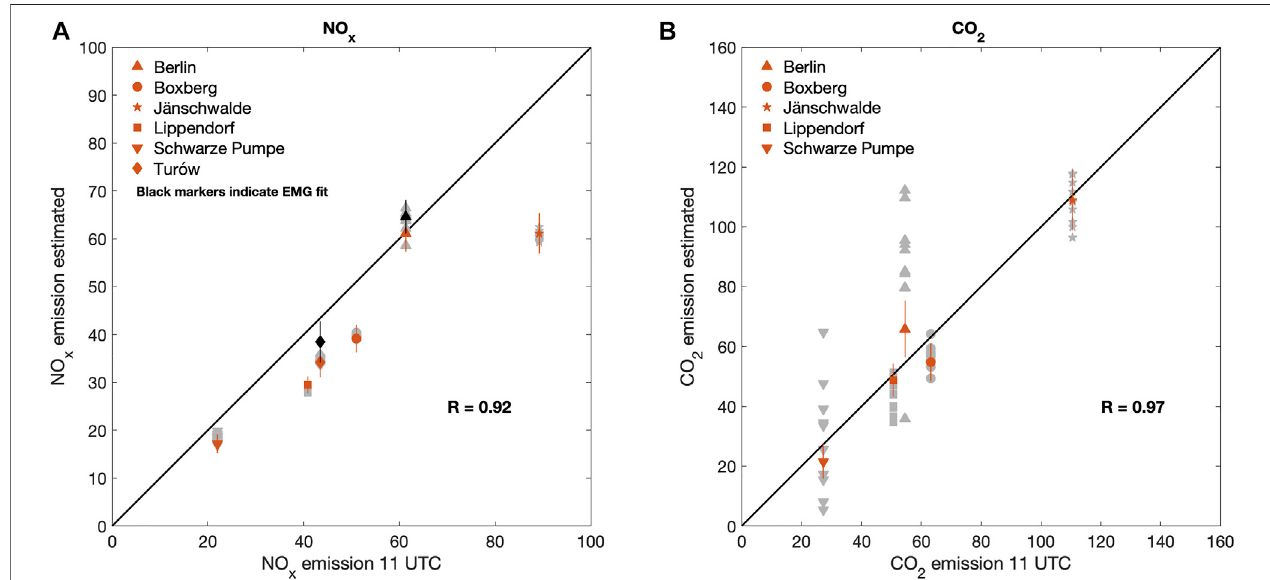
FIGURE 4 | Source-speci fi c emissions for NO x (A) and CO 2 (B) . Orange symbols indicate the emissions calculated from the CO 2 divergence map shown in Figure 3F (denoised and with background removed) and from the NO x emission map shown in the Supplement ( Supplementary Figure S4 ) using peak fi tting. Grey